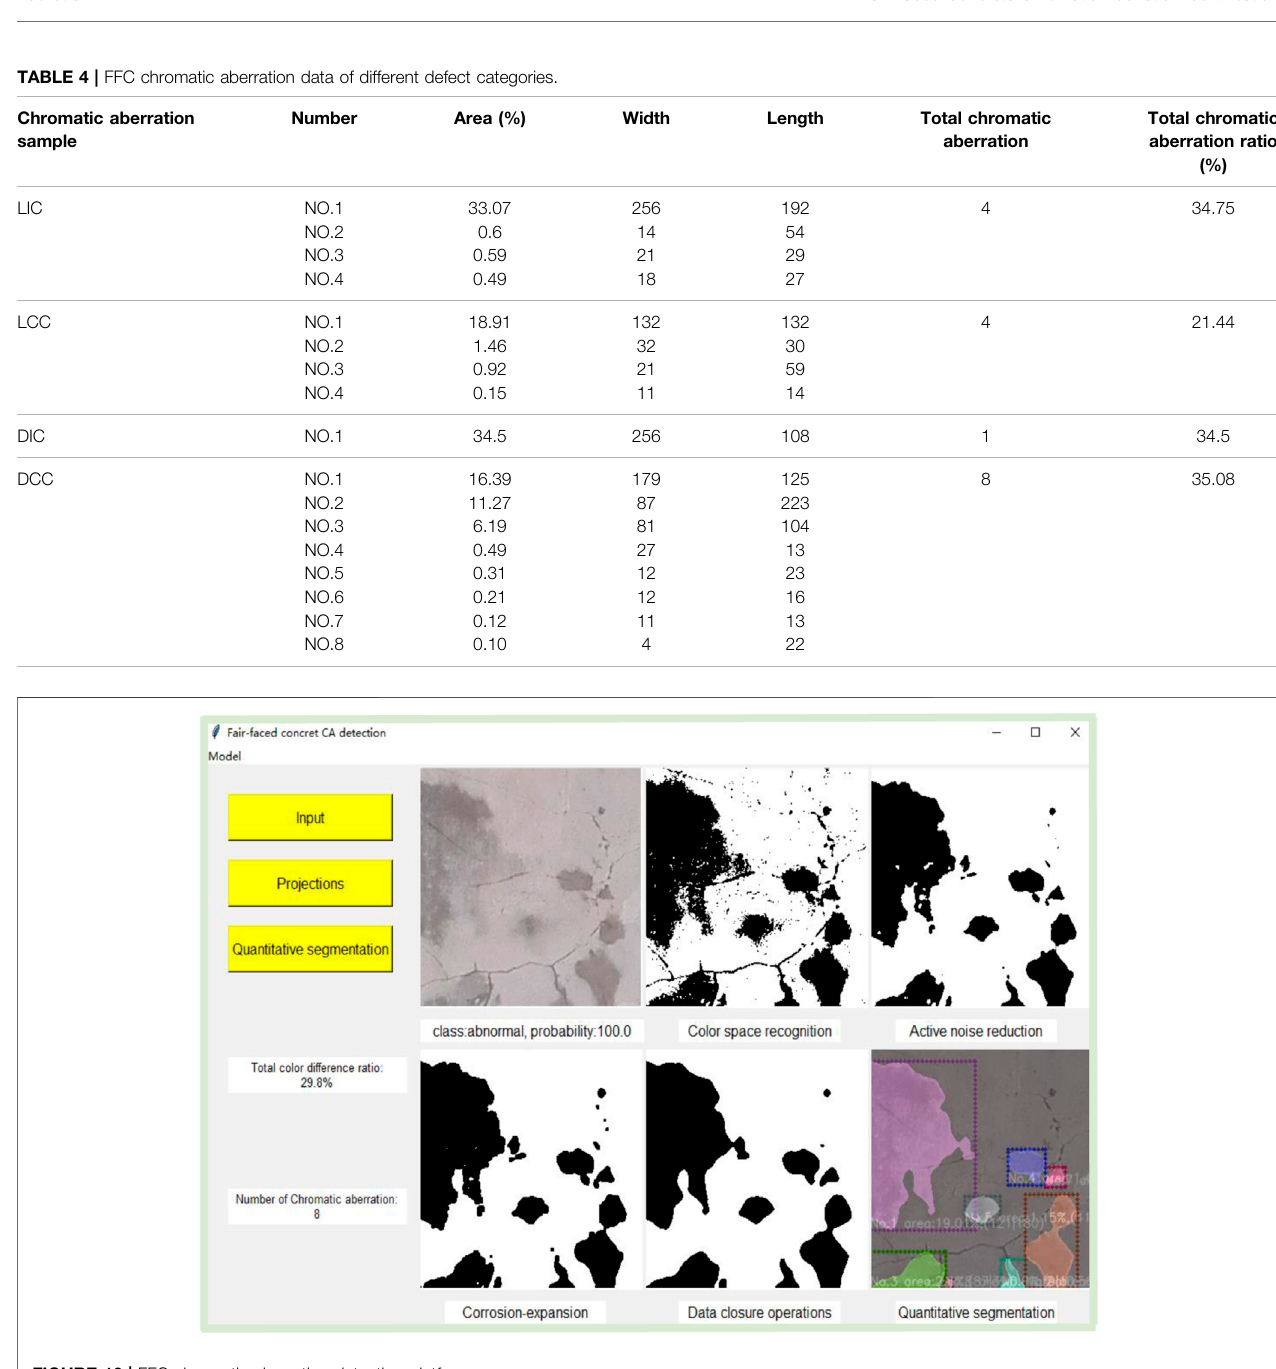
FIGURE 16 | FFC chromatic aberration detection